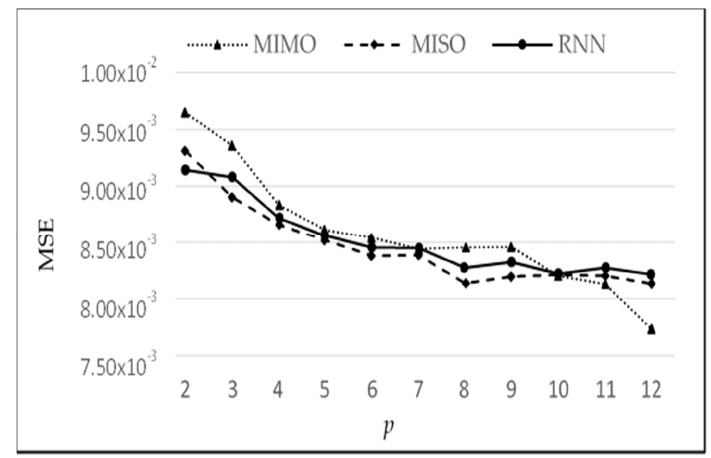
Figure 13. MSE vs. Lags for MIMO, MISO, and RNN.